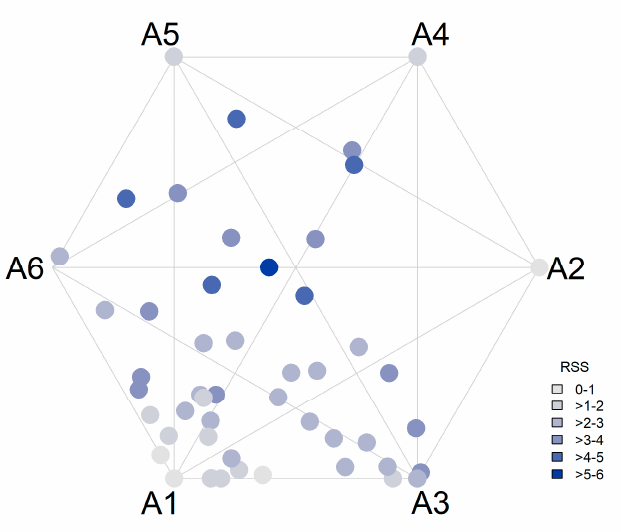
Figure 15. Simplex plot with the RSS of six archetypes (with light grey/blue colors indicating low and dark blue colors indicating high RSS